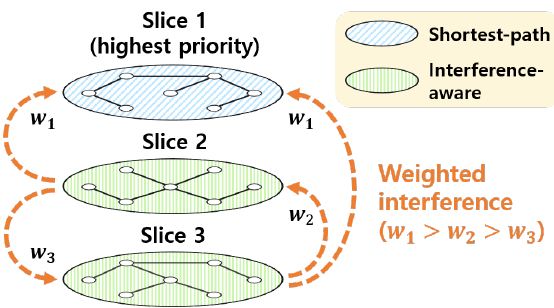
Figure 2. An example of prioritized multiple